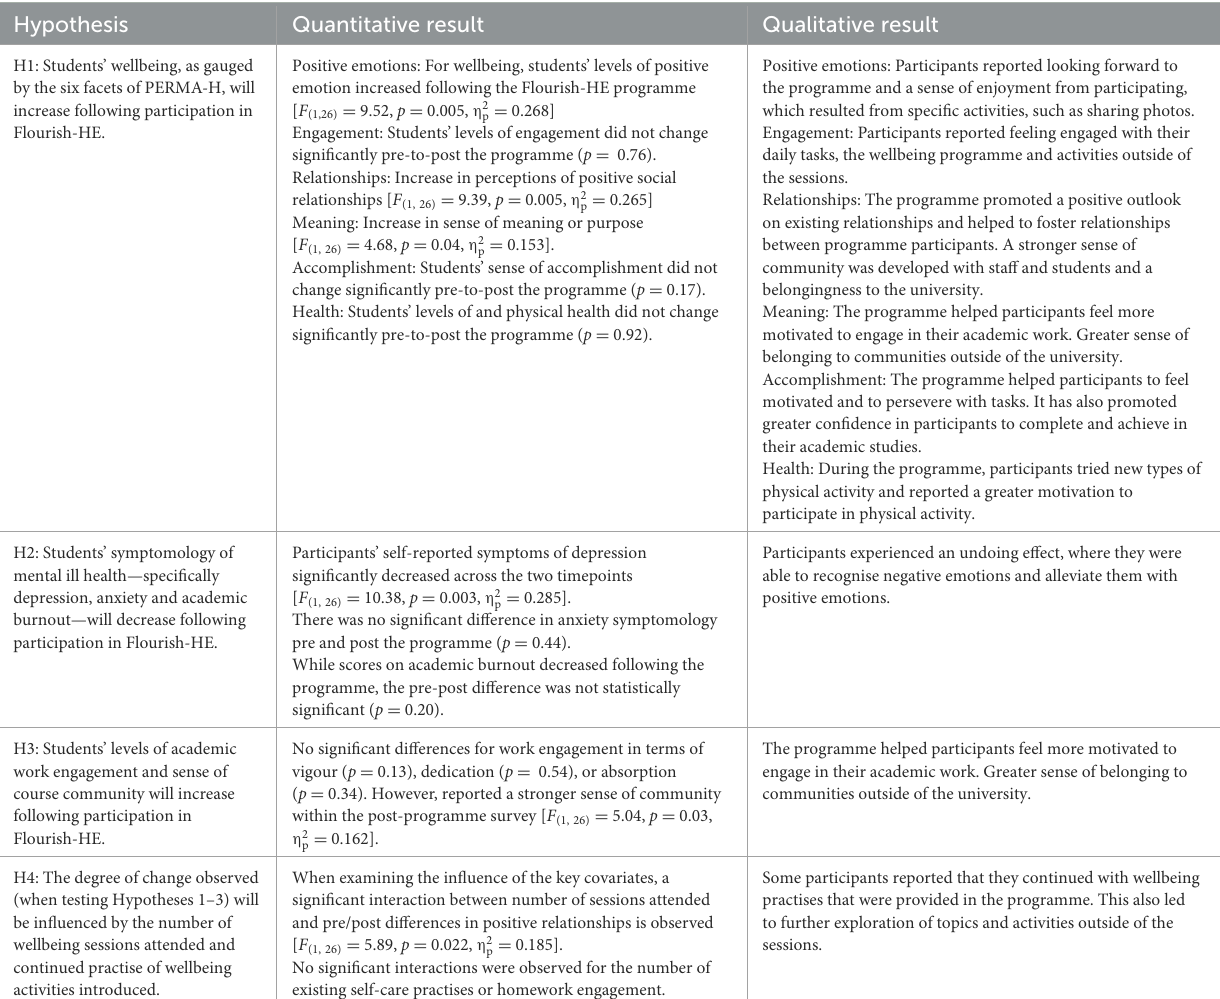
TABLE 4 Overview of hypotheses and integration of quantitative and qualitative results. Hypothesis Quantitative result Qualitative